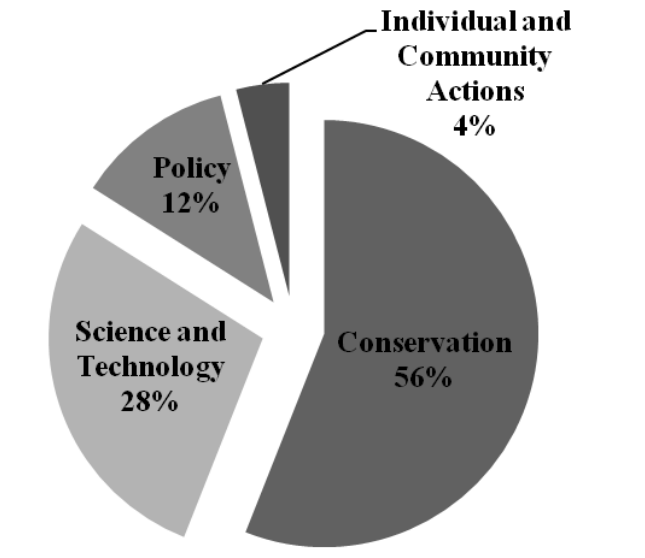
Figure 1. Distribution of given recommendations regarding biodiversity management in the face of climate change among different sectors; adapted